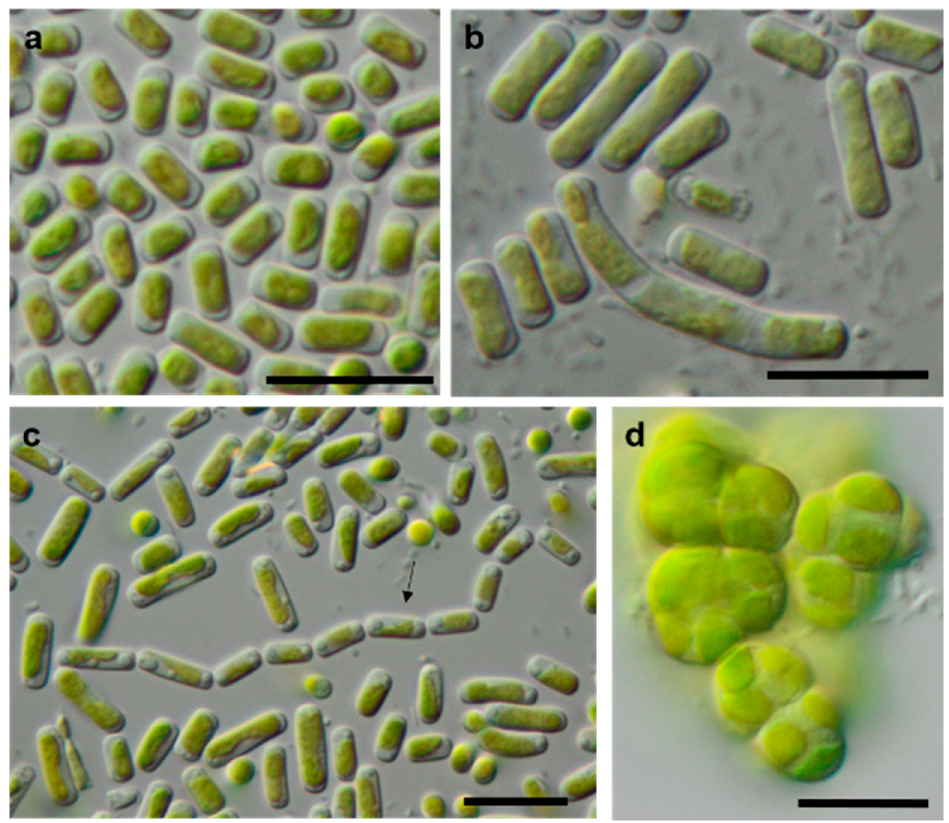
Figure 12. Photomicrographs of Trebouxiophyceae isolates. ( a,c ): Pseudostichococcus monallantoides WT-3-1-A ( a ) young cells and ( c ) mature cells forming a filament (arrow)), ( b ) Pseudostichococcus monallantoides SY-1-2-X, and ( d ) Diplosphaera chodatii SY-1-2-K with cubic cell packages. Scale bars: 10 µm.